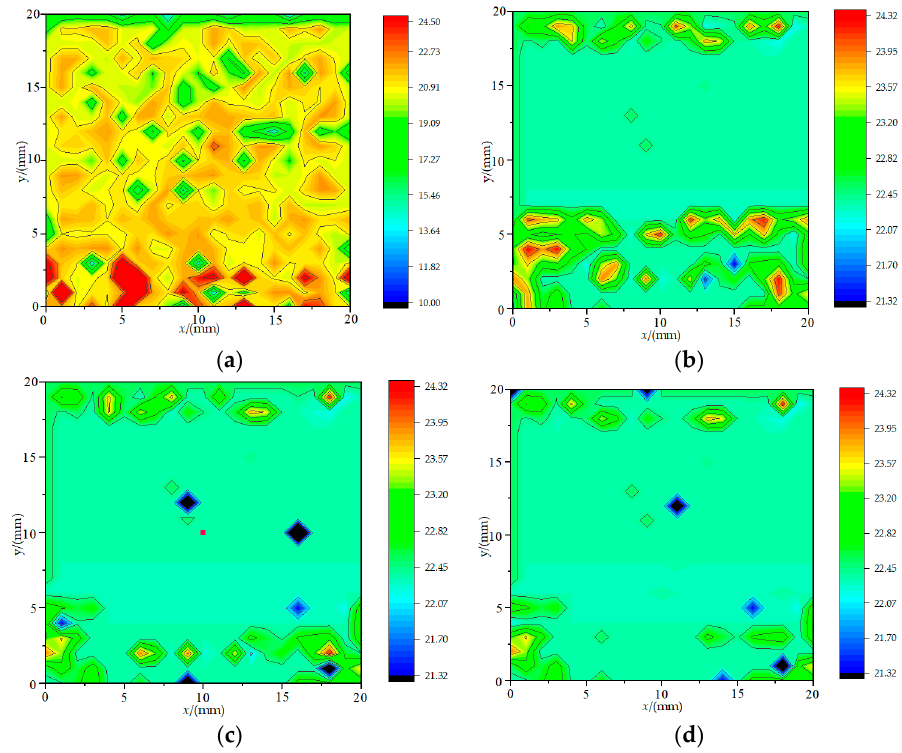
Figure 10. ( a ) Uniformity of coverage at F2K1 level; ( b ) Uniformity of coverage at F2K2 level; ( c ) Uniformity of coverage at F2K3 level; ( d ) Uniformity of coverage at F2K4 level. The importance of coverage uniformity was higher than specific power